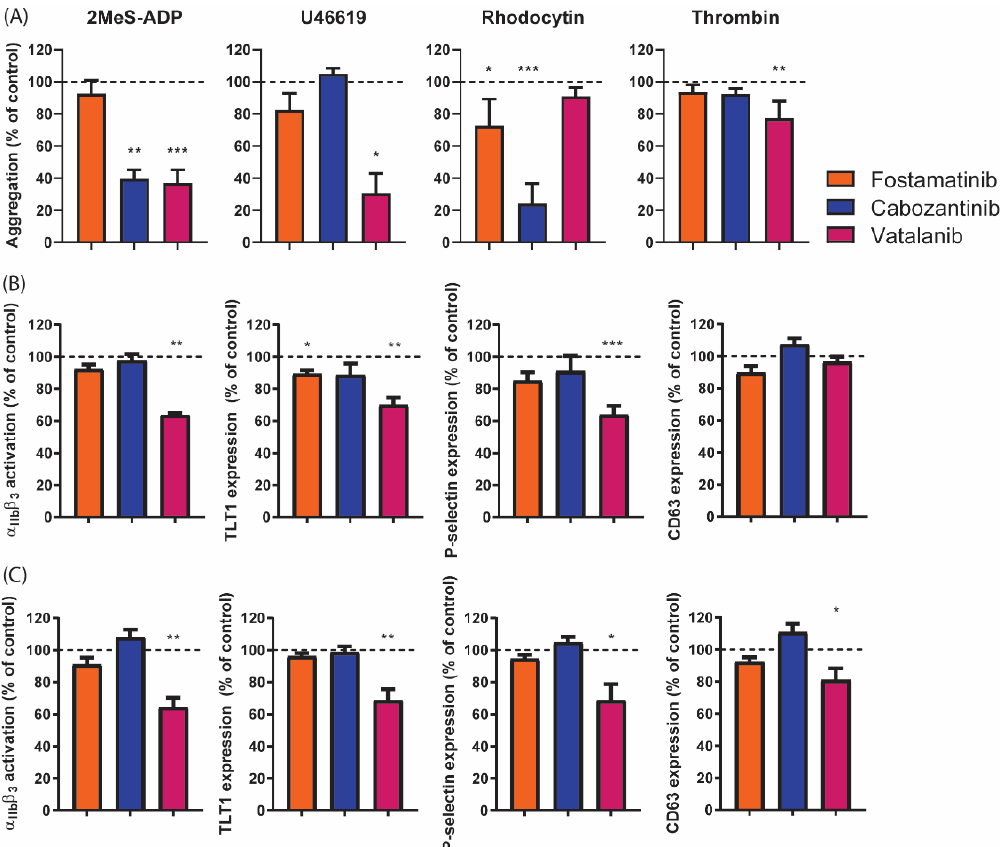
Figure 6. Platelet aggregation and activation induced by different activation pathways in the presence of different TKIs. ( A ) Washed platelets (250 × 10 9 /L) were incubated with vehicle (control), fostamatinib (33 µM), cabozantinib (33 µM), or vatalanib (33 µM) for 10 min. Platelet aggregation was then induced with 1 µM of 2MeS-ADP, 1 µM of U46619 (thromboxane A2 analogue), 1 µg/mL of rhodocytin, or 4 nM of thrombin. Aggregation responses were measured for 8 min. Histograms show aggregation as a percentage of the control (dotted line). ( B , C ) Washed platelets (25 × 10 9 /L) were incubated with the vehicle (control) or TKI for 10 min. Platelets were activated by ( B ) 2 µ M of 2MeS-ADP or ( C ) 4 nM of thrombin for 15 min. Simultaneous labeling was performed for activated integrin α IIb β 3 (PAC1-FITC), α -granule secretion ( α TLT1-BV421, α CD62P-PerCP Cy5.5), and δ -granule/lysosome secretion ( α CD63-APC). Histograms for integrin α IIb β 3 activation, TLT1, P-selectin, and CD63 expression are given as percentages of the control condition (dotted line). Data are shown as means ± SEM ( n = 6); * p < 0.05, ** p < 0.01, and *** p <